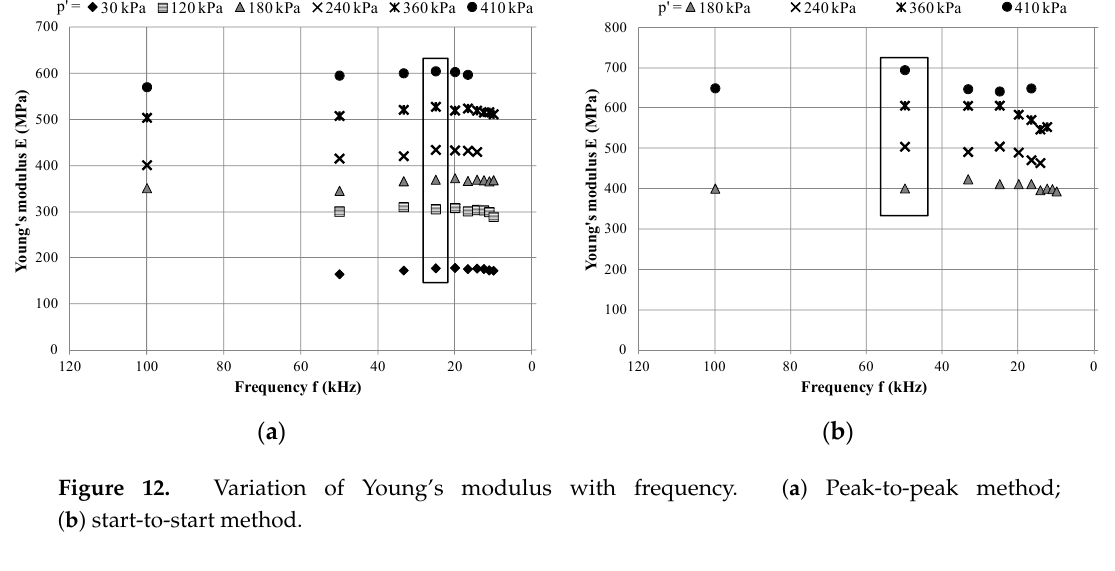
Figure 12. Variation of Young’s modulus with frequency. ( a ) Peak-to-peak method; ( b ) start-to-start method.